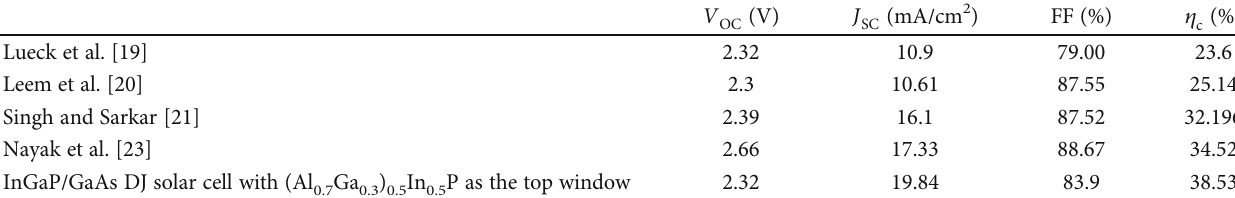
Table 5: Comparison of simulated performance parameters of di ff erent DJ solar cells under 1 sun of the standard AM1.5G solar spectrum at